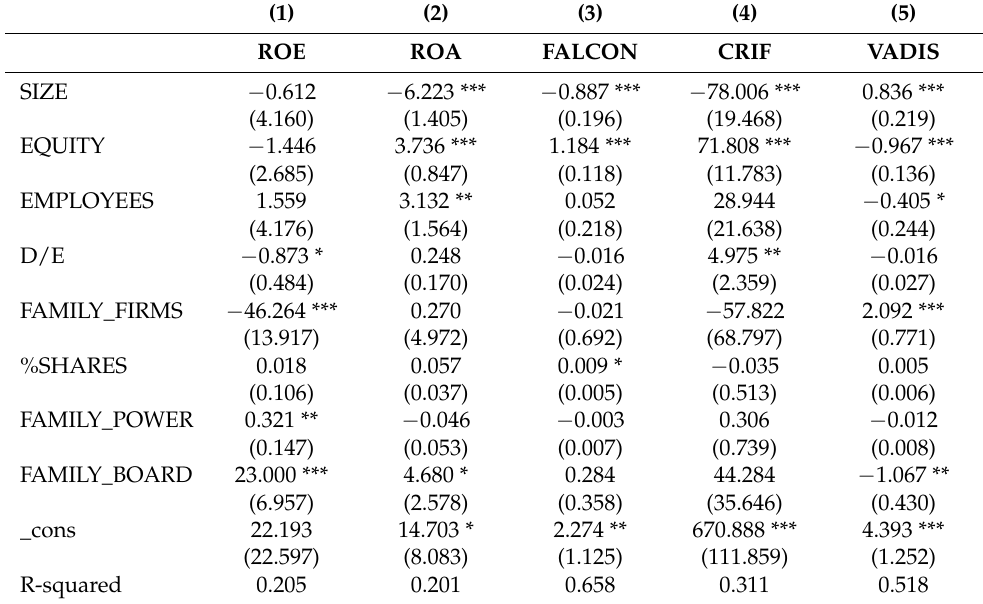
Table 4. Regression